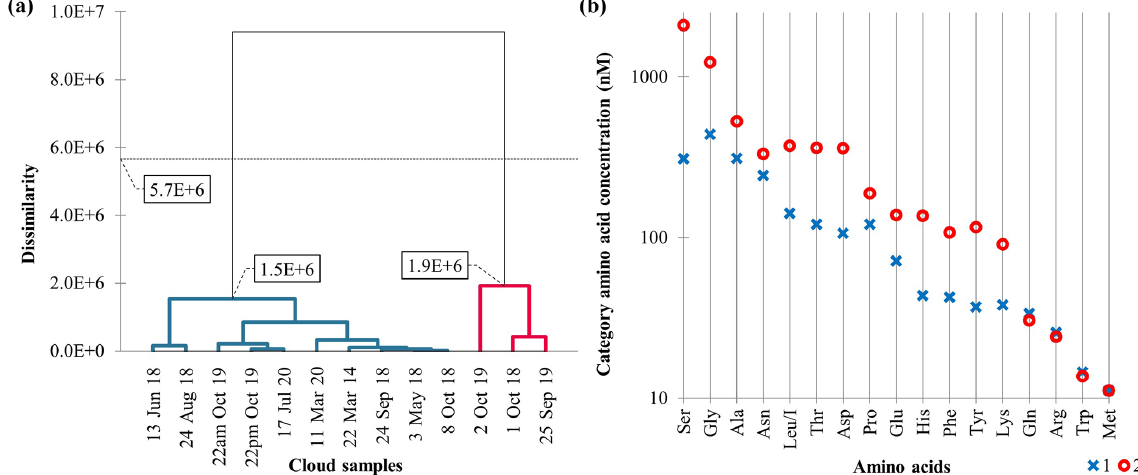
Figure 4. (a) Dendrogram representing the agglomerative hierarchical clustering (AHC) based on dissimilarities using Ward’s method on concentrations of the 18 AAs. The 13 cloud samples are assigned to one of two established categories by entropy (i.e., dissimilarity < 5 . 7 × 10 6 ). (b) Profile plot established by the AHC from the 18 main AAs. The y axis, in logarithmic scale, displays the average AA concentrations of the